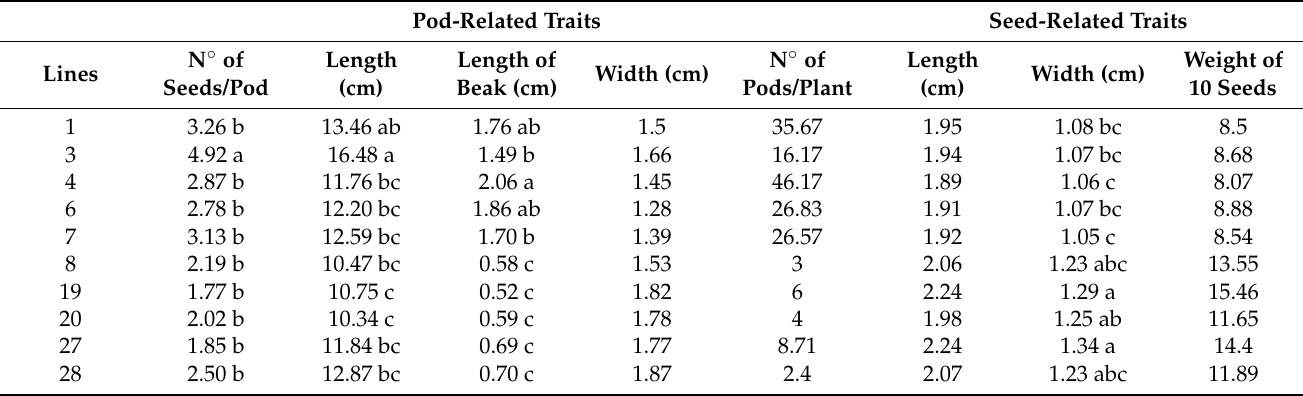
Table 4. Quantitative traits related to the size and number of pods and seeds of P. coccineus lines. The values are the averages of the six repetitions for each line. The letters next to the means indicate the significance for the difference between the means of each trait analyzed using the Tuckey test. Only different letters mean significant differences. Traits without letters do not vary significantly between